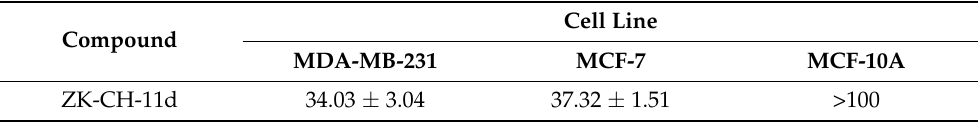
Table 3. IC 50 ( µ mol/L) of ZK-CH-11d on breast cancer cell line MDA-MB-231 and MCF-7 and non-cancer cell line